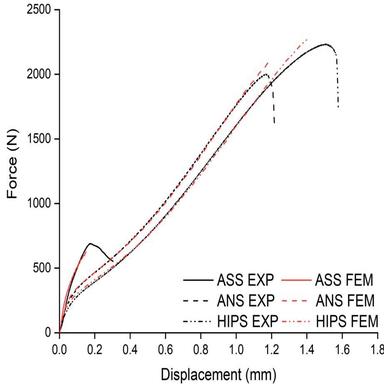
Force-displacement curves of SPT for 316L steel: experimental data compared with the results of the forward analysis.